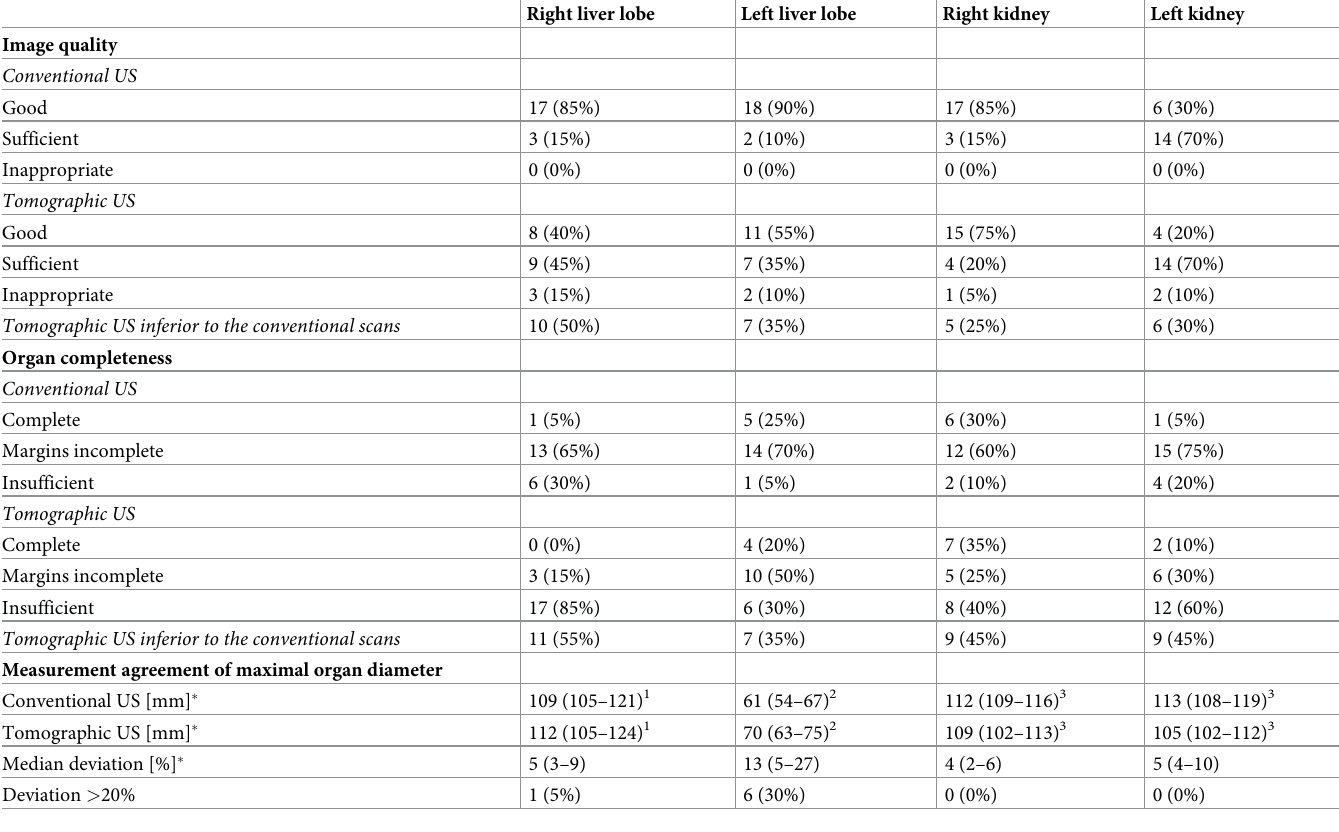
Table 1. Comparison of tomographic and conventional ultrasound in the training